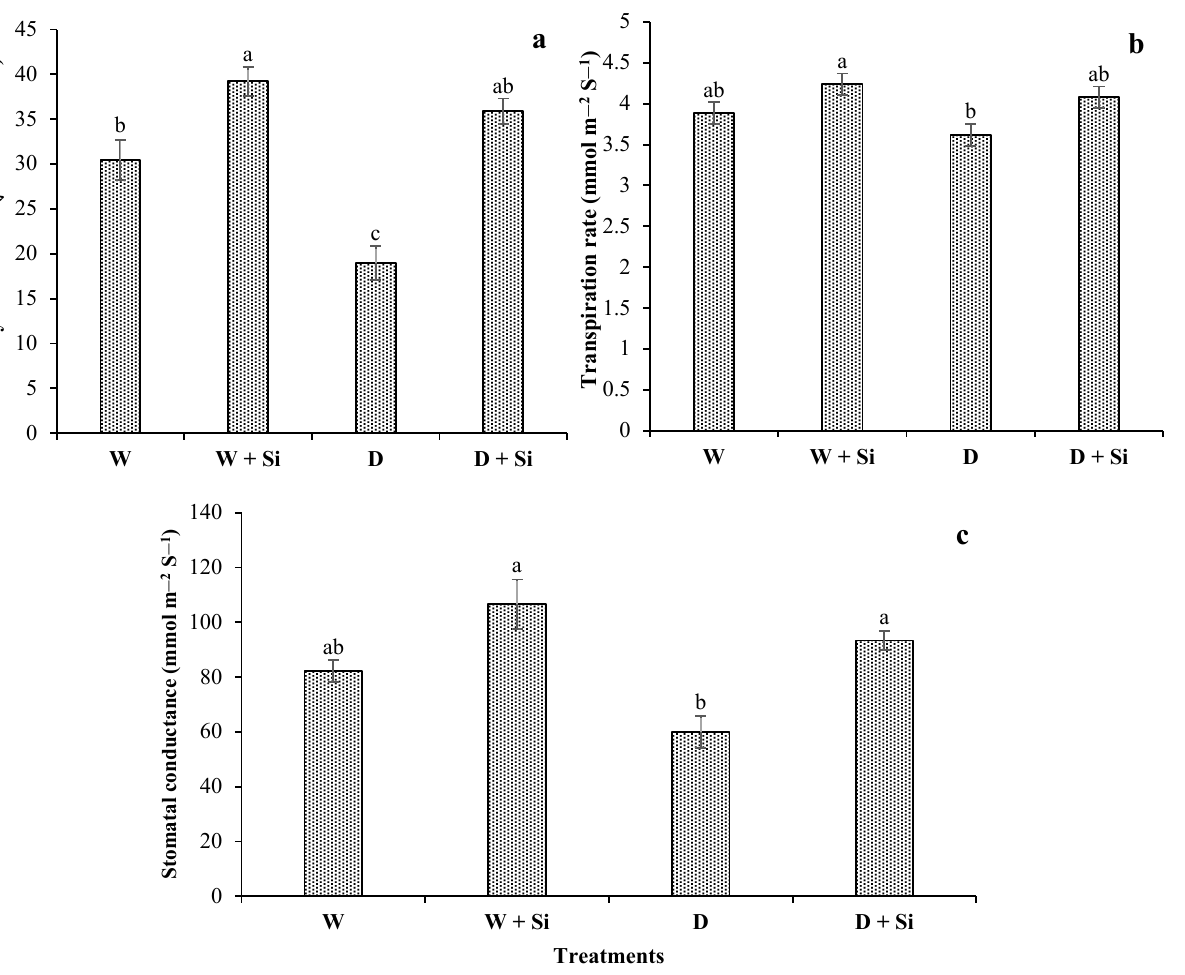
Figure 6. Impact of foliar Si supplementation on photosynthetic rate ( a ), transpiration rate ( b ), and stomatal conductance ( c ) of Gerbera jamesonii under water-deficient conditions. Each bar shows an average of four replicates ± SE. Dissimilar lettering illustrates significant statistical differences at p ≤ 0.05 after applying LSD test.